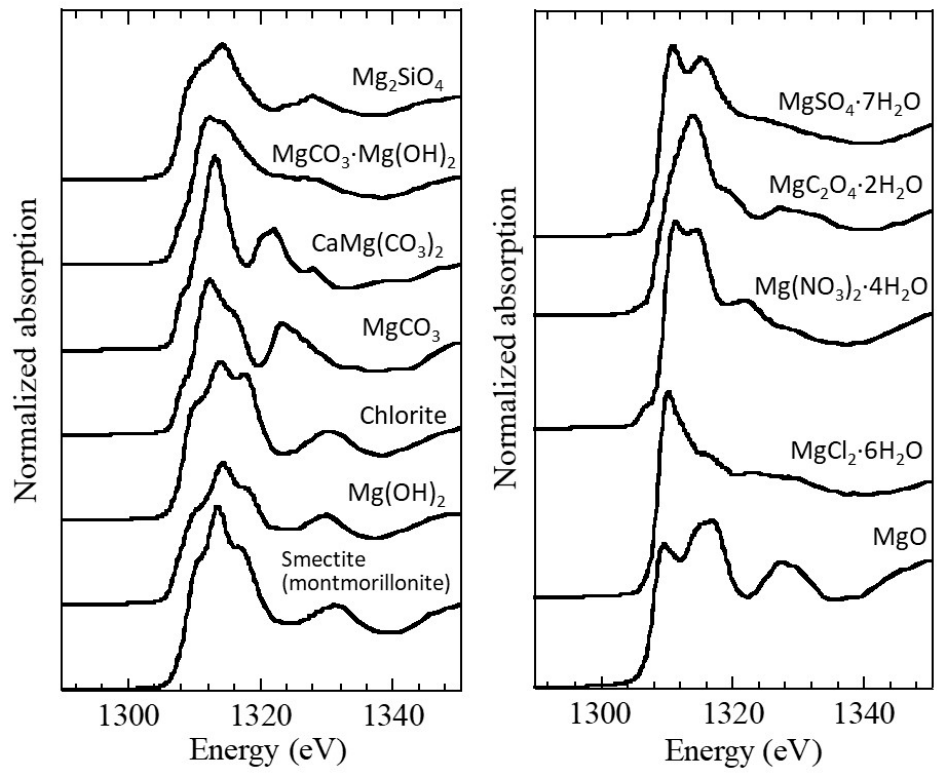
Figure 6. Mg K-edge XANES spectra of ( a ) Mg in natural minerals and ( b ) Mg in other Mg species.